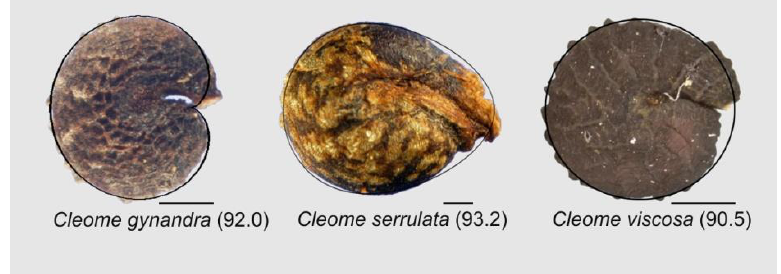
Figure 2. Cleome species ( Cleome gynandra , Cleome serrulata and Cleome viscosa ) in the Cleomaceae (Brassicales) give high J index values in parentheses with cardioid, oval and ellipse models, respectively. Bars equal to 0.5 mm. Cleome gynandra and Cleome serrulata seed images are from the USDA Plants Database (https://plants.sc.egov.usda.gov/java/). Cleome viscosa seed image is from Seeds of South Australia (https://spapps.environment.sa.gov.au/SeedsOfSA/home.html).